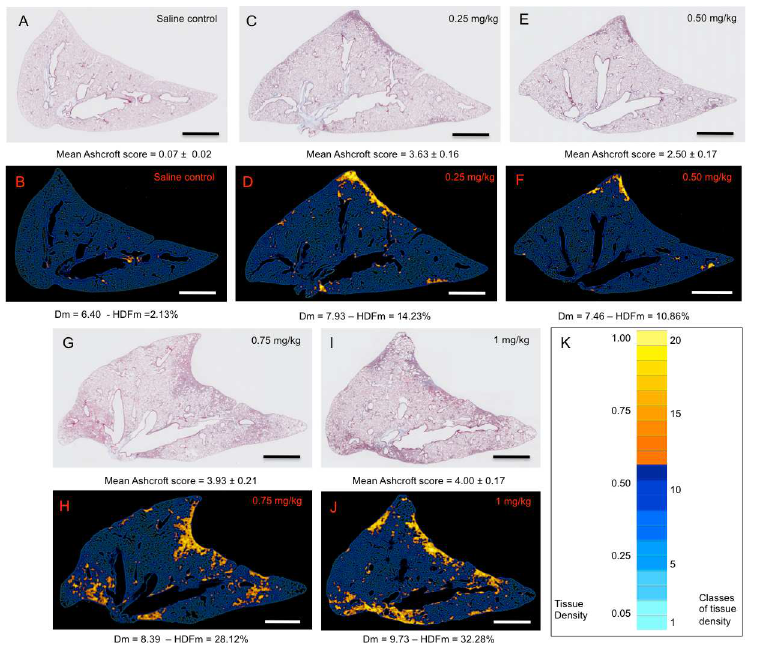
Fig 3. Representativeoriginal imagesof Massontrichrome stainedlung sectionsand their correspond- ing automated2D-reconstructed imagesaccording to their respectivelung tissuedensity values. Original images(A, C, E, G, I) correspond to representative Massontrichromestainedlungsectionsfrom salinecontrol (A) and BLM-treated lungsat 0.25mg/kg(C), 0.50mg/kg(E), 0.75mg/kg(G) and1 mg/kg (I). Reconstructed-2D lungsectionsof theirrespective originalimageswereobtainedby gradingtheirtissuedensity values,obtained from thousandsmicro-tiles, in20 classesof increasingvalues.Pseudocolourswerethenassignedto tissue densitiesaccording to theirclassfrom lightblue(lowdensityvalues)to yellow(highdensityvalues)(K). For each originalimageof salinecontrolandBLM-treated lungsthe valueof theirAscroft score(mean ± s.e.m.) was indicated.Regarding theircorresponding2D-reconstructed imagesthe valueof theirDm (mean ± s.e.m.) and HDFmwasindicated,respectively. Notethat highdensityvaluesvisualized in 2D-reconstructedimageswere focalizedinfibroticregionsevidencedin theircorrespondingMassontrichromestainedlungsections. Scalebars: 1 mm.